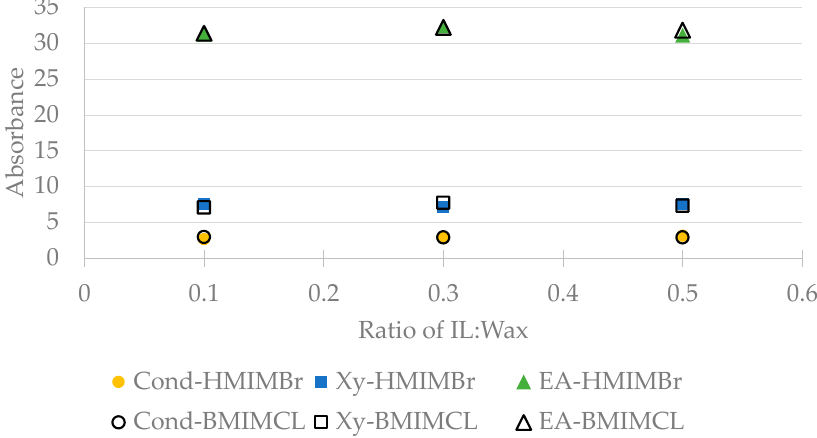
Figure 6. UV-VIS absorbance of soak solvent in the presence of ionic liquid at 0.5 h of soaking time.